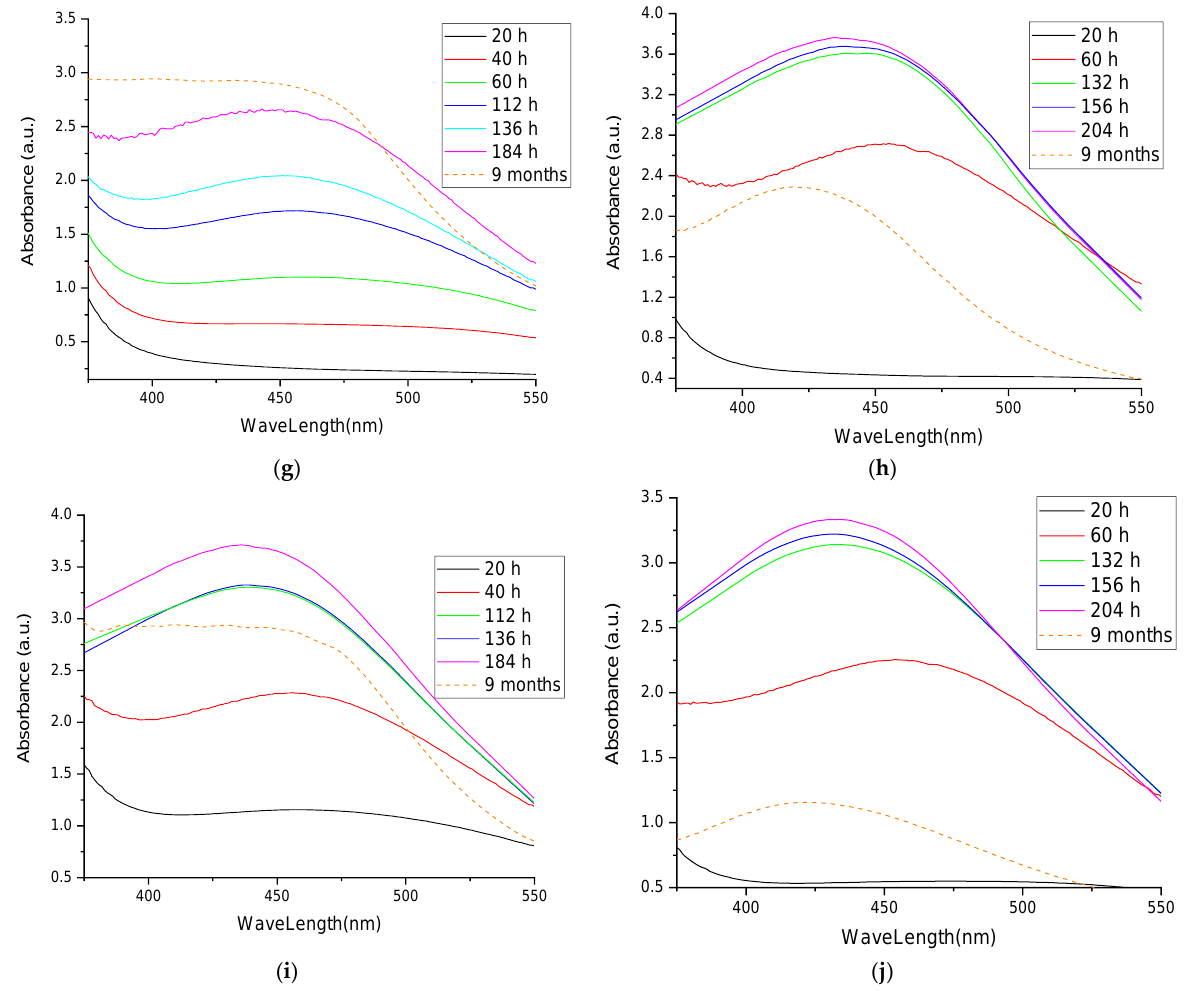
Figure 2. UV-Vis spectra of the obtained nanoparticle solutions: ( a ) sample EE5; ( b ) sample EE2.5; ( c ) sample EE2; ( d ) sample EE1.25; ( e ) sample EE1; ( f ) sample EM5; ( g ) sample EM2.5; ( h ) sample EM2; ( i ) sample EM1.25; ( j ) sample EM1.